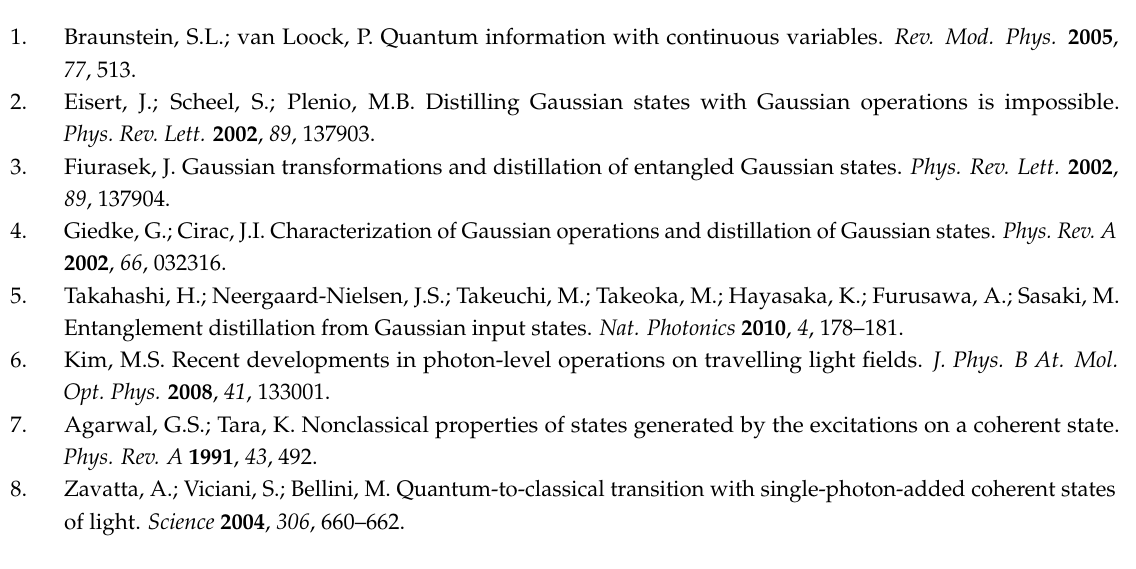
Figure 10. Plots of the joint probability distribution of the detected number of photons Pr n (cid:48) input quantum vortex | 1 + (cid:105) with s = 0.5. Left : ideal case. Center : realistic case with µ = 0.88 and ¯ n th → 0. Right : realistic case with µ = 0.24 and ¯ n th = 10 − 7